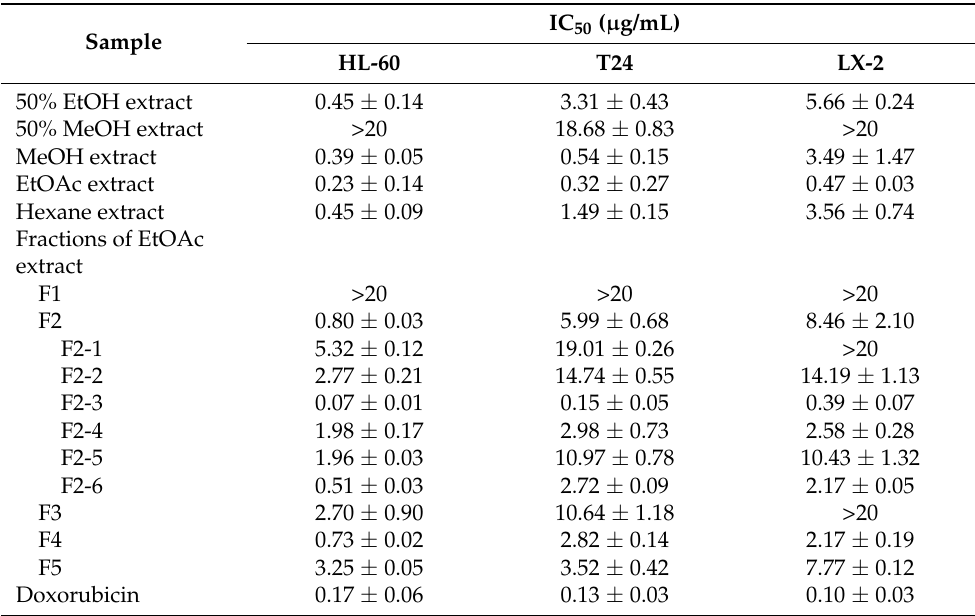
Table 1. Antiproliferative activity of different samples of T. ruticarpum fruit against three different human cell